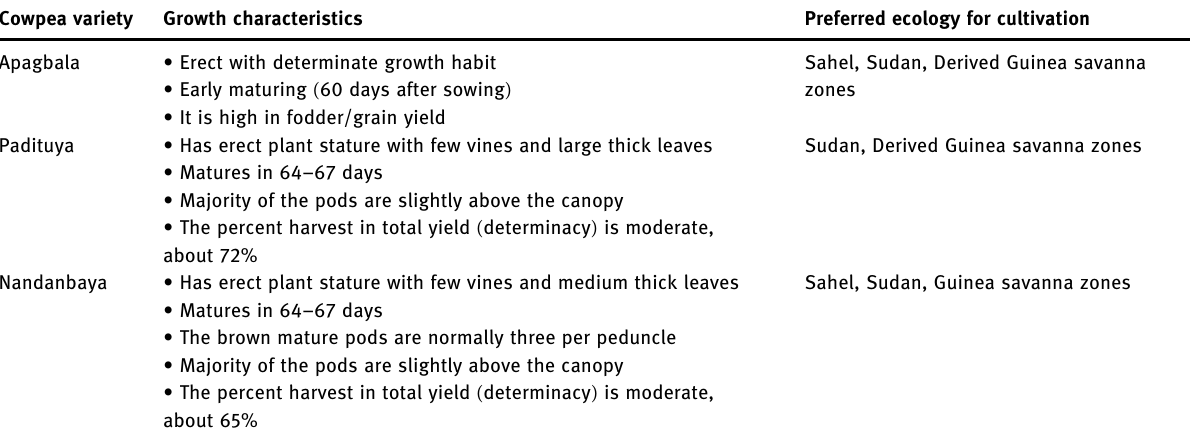
Table 1: Growth characteristics and preferred ecology for cultivation of the three cowpea varieties Cowpea